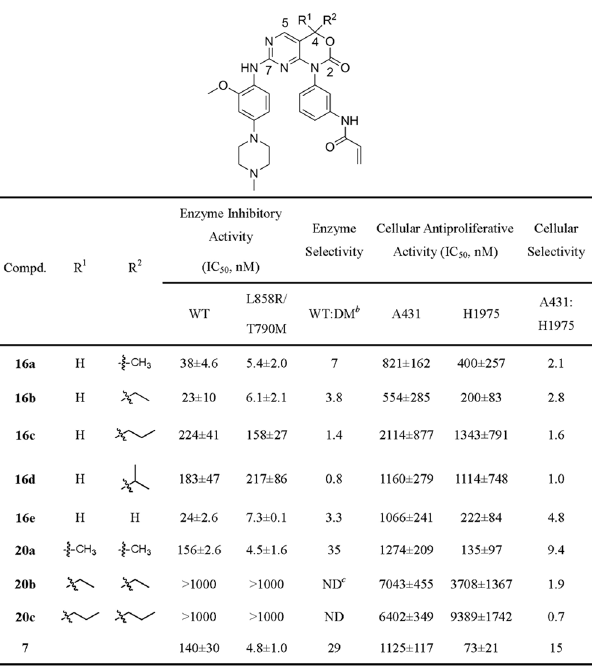
Figure 5. In Vitro Enzyme Inhibitory Activities and Cellular Antiproliferative Activities of Compounds 16a-e, 20a-c a . a Kinase activities were determined through using the ELISA-based EGFR-TK assay. In vitro antiproliferation activities of the compounds were examined through using the sulforhodamine B (SRB) colourimetric assay. IC 50 values are averages of at least three independent determinations and reported as the means ± standard deviations (SD). b Dual-mutant (EGFR L858R/T790M ). c Not